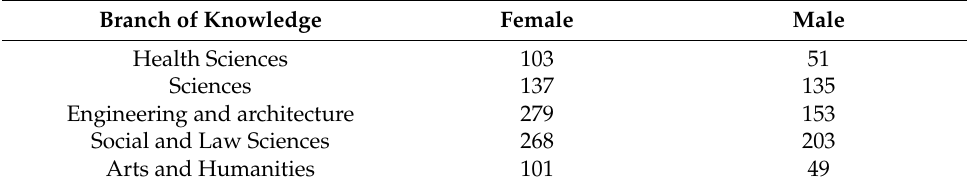
Table 2. Distribution of responses by field of knowledge and gender. Branch of Knowledge